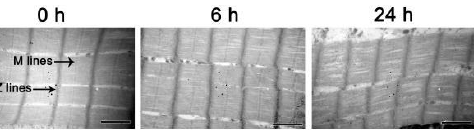
Figure 2. Transmission electron microscopy (TEM) images of longissimus lumborum muscles during postmortem storage. Table 2. Total sulfhydryl content, MFI (myofibril fragmentation index), and sarcomere length of Longissimus lumborum muscles during postmortem storage.